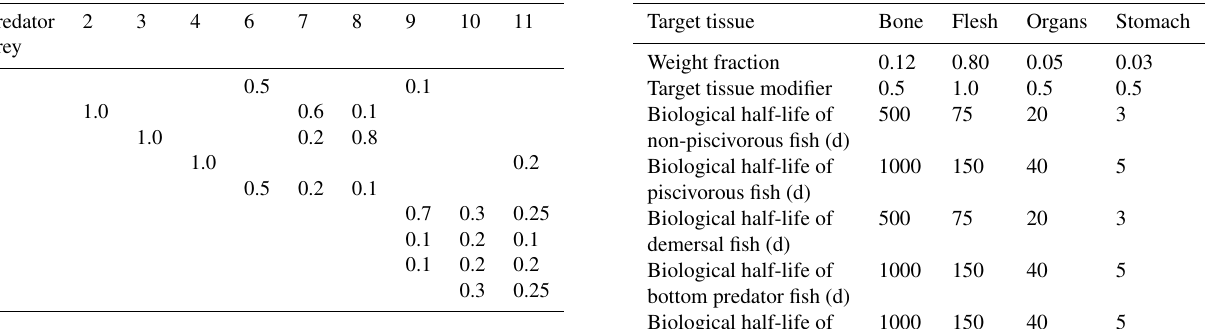
Table 3. Parameters for fish in a dynamic food chain